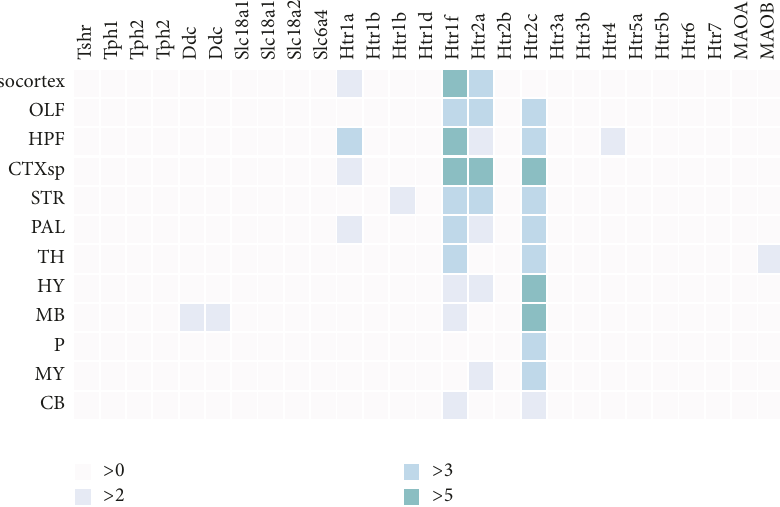
Figure 3: Expression of serotonin genes in each of the brain structures of the C57BL/6J mouse using ABADV.